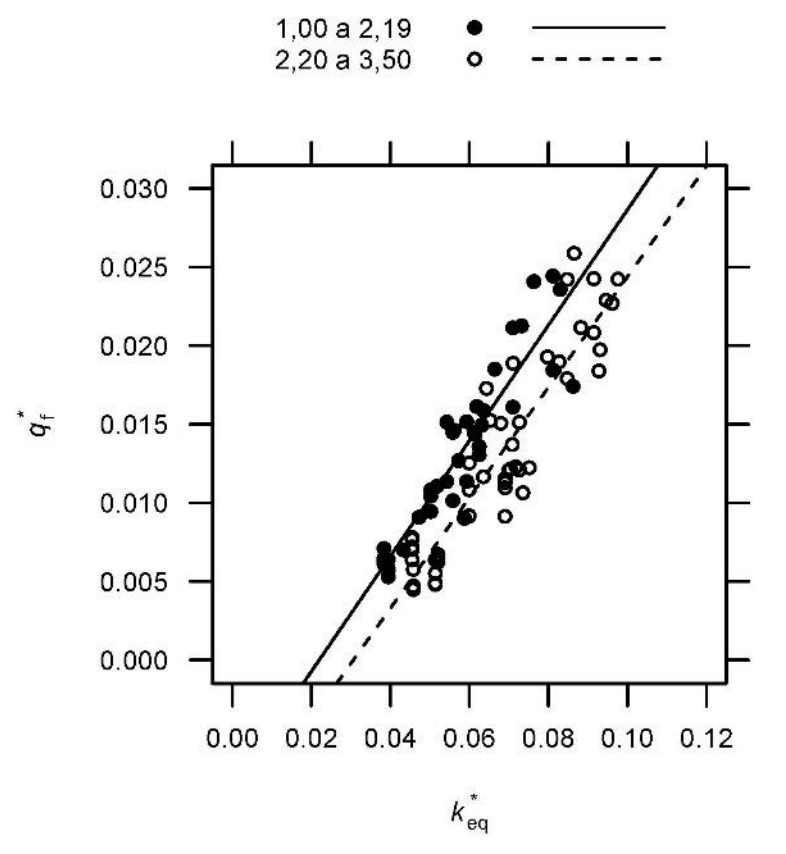
Figure 14. Variation of 𝑞 f∗ with 𝑘 eq∗ differentiating by the downstream slope steepness.